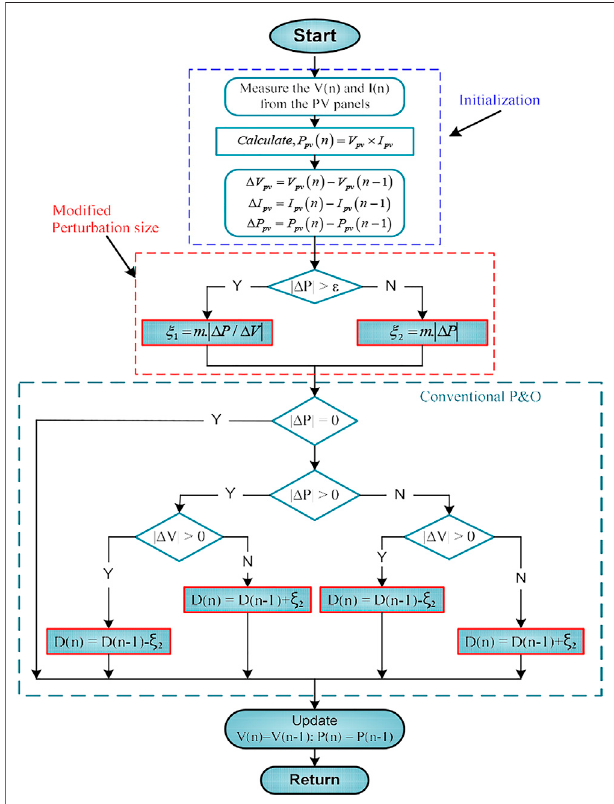
FIGURE 6 | Flowchart of the proposed variable step MPPT